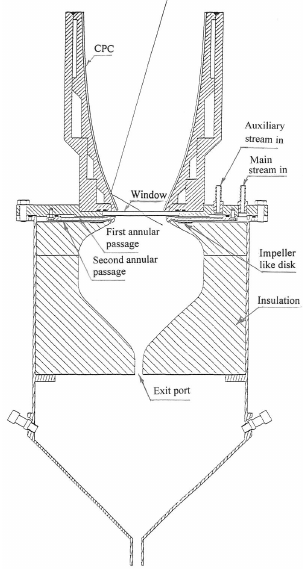
Figure 13. Reactor configuration analyzed by Kogan and Kogan. Reprinted from [122] with permission from